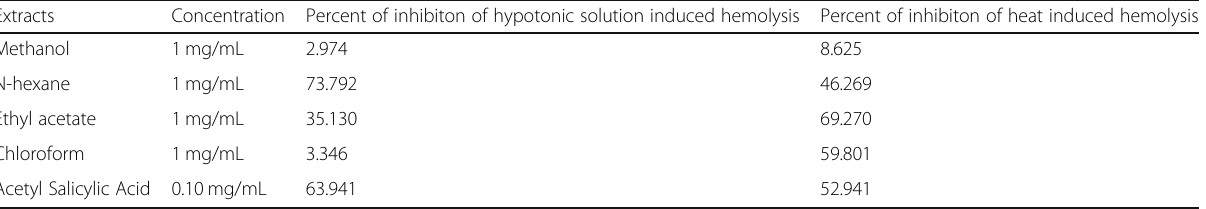
Table 3 Membrane stabilizing potential of different extracts of Cheilanthes tenuifolia